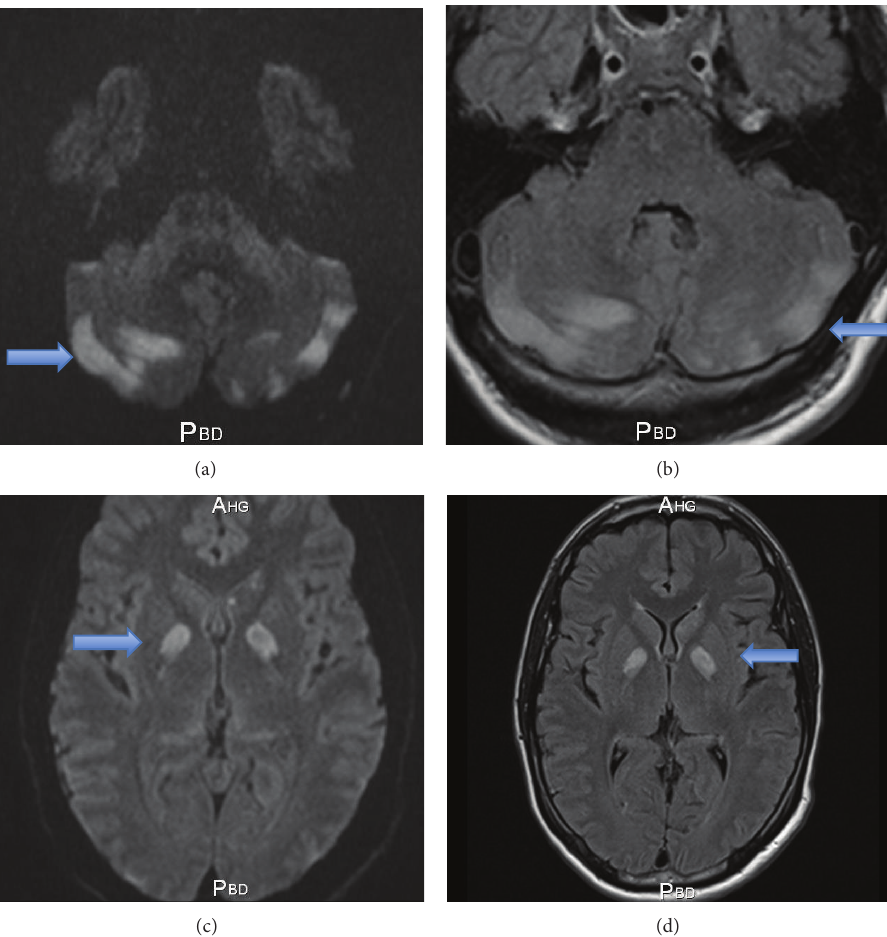
Figure 1: Cerebral IRM showing FLAIR (on the left side) and DWI (on the right) hyperintensities in both cerebellar hemispheres (panels (a)-(b)) and basal ganglia (panels